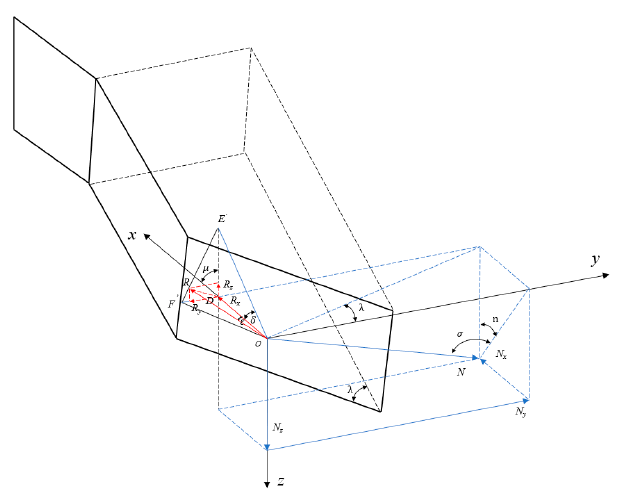
Figure 3. Force analysis diagram of dividing plate.